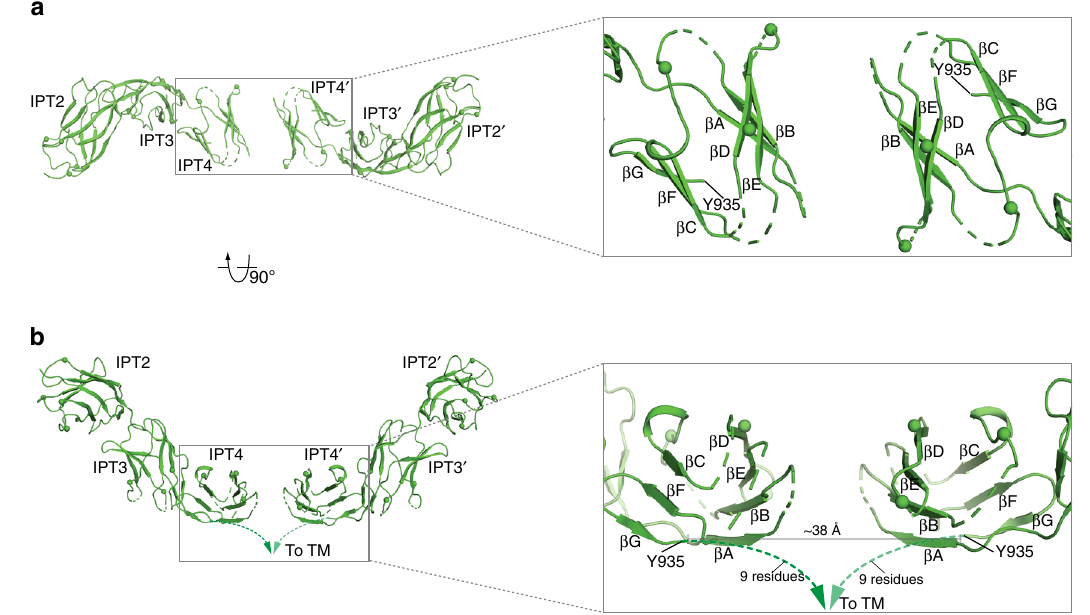
Fig. 3 Close juxtaposition of the IPT2 – 4 domains in the PlexinC1/A39R complex structure. The two protomers of the IPT2 – 4 domains of PlexinC1 in the dimeric PlexinC1/A39R complex are shown in two orthogonal views. The right panels show the expanded views of the two IPT4 domains, which are juxtaposed in an antiparallel fashion. Note the C ′ strand in IPT4 is not modeled due to the lack of clear density. Spheres indicate the glycosylation sites. TM transmembrane region. Dashed lines indicate the 9-residue linker between IPT4 and TM.